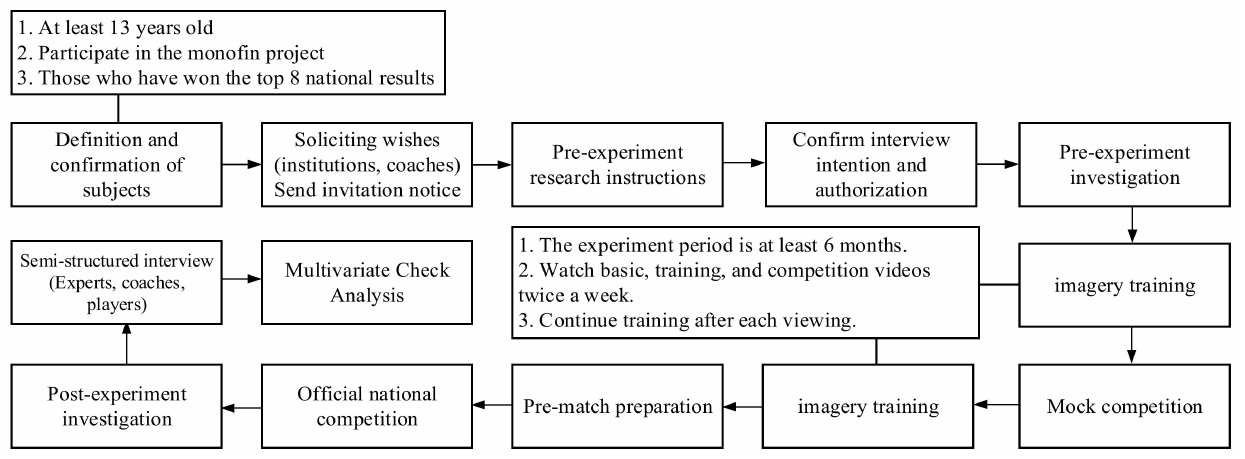
Figure 2. Experimental design specifications and